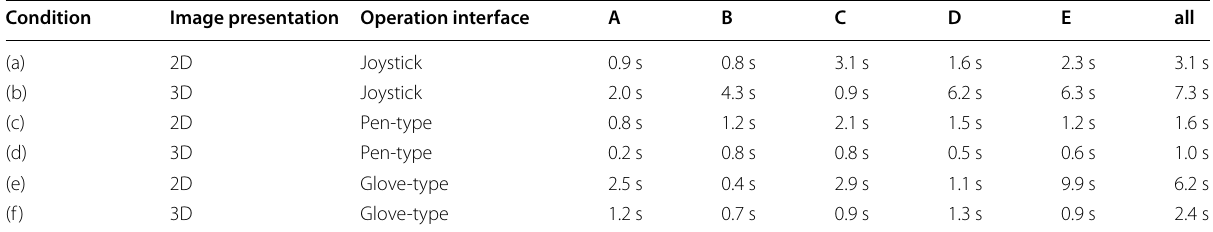
Table 7 Standard deviation of time to complete a task